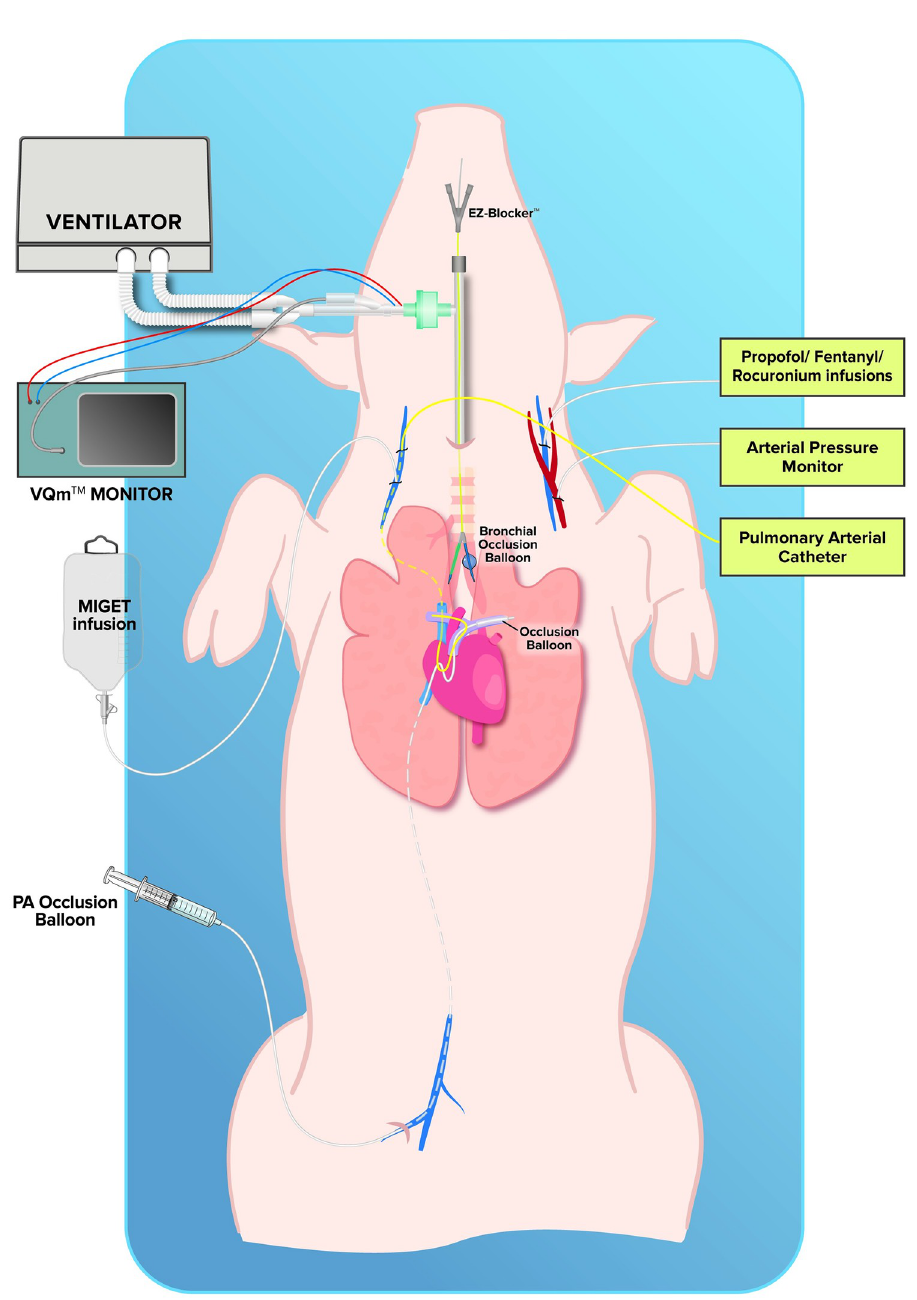
Fig 2. Experimental setup. MIGET = multiple inert gas elimination technique; PA = pulmonary artery. single-lung ventilation and repeated whole-lung lavage) and etCO left main pulmonary artery) S repeated whole-lung lavage) and SpO dynamic parameters are shown in Table 2.